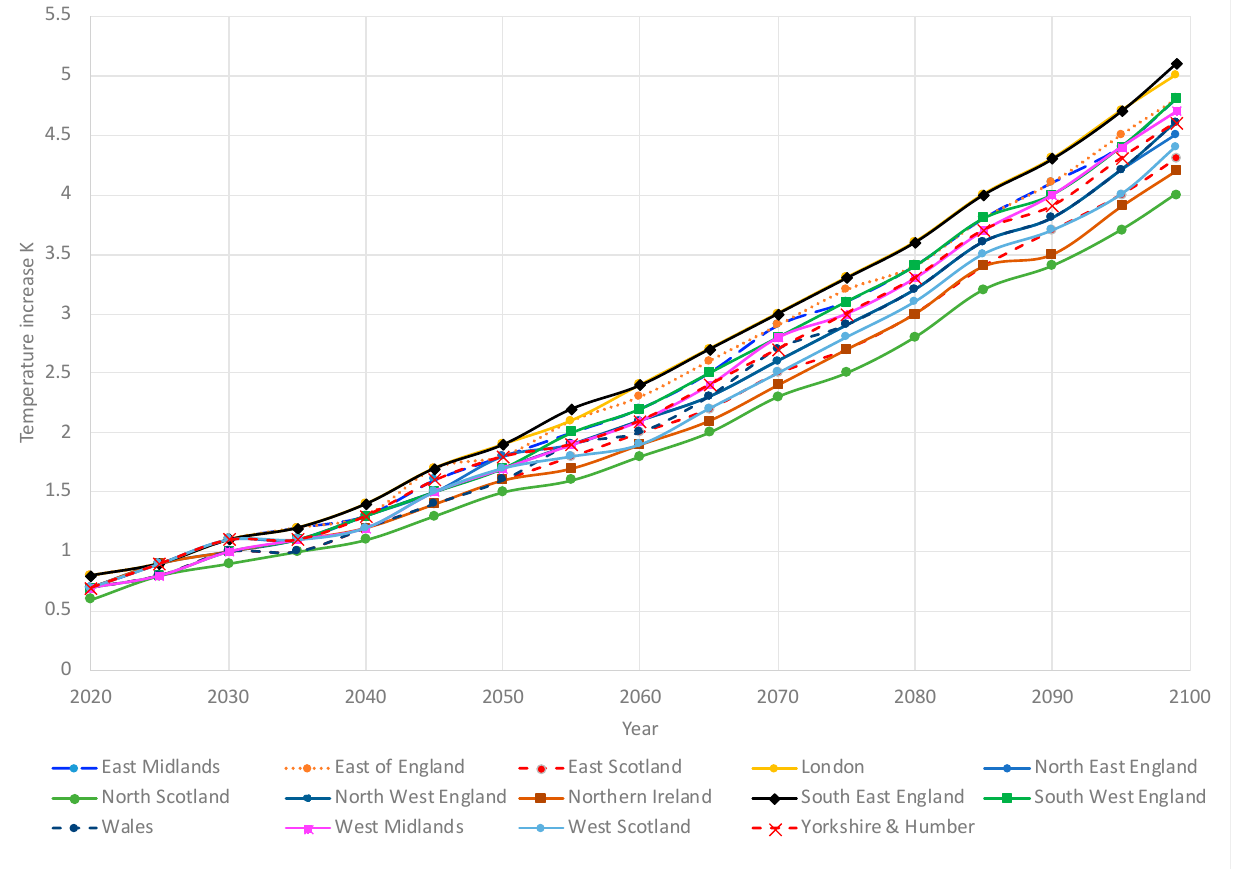
Figure 2. Temperature changes compared with 1981–2000 baseline (air at 1.5 m), for 2018 RCP 8.5, similar to the 2009 high-emission scenario used in this study. Chart created by author from UK Climate Projections User Interface (UKCP18 data).